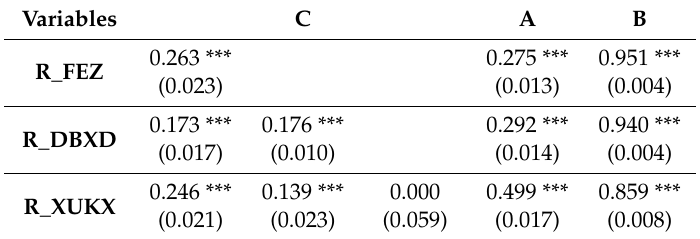
Table 9. Diagonal BEKK for Europe Market ETF returns (whole period) (10 September 2007 to 30 March 2015). Variables